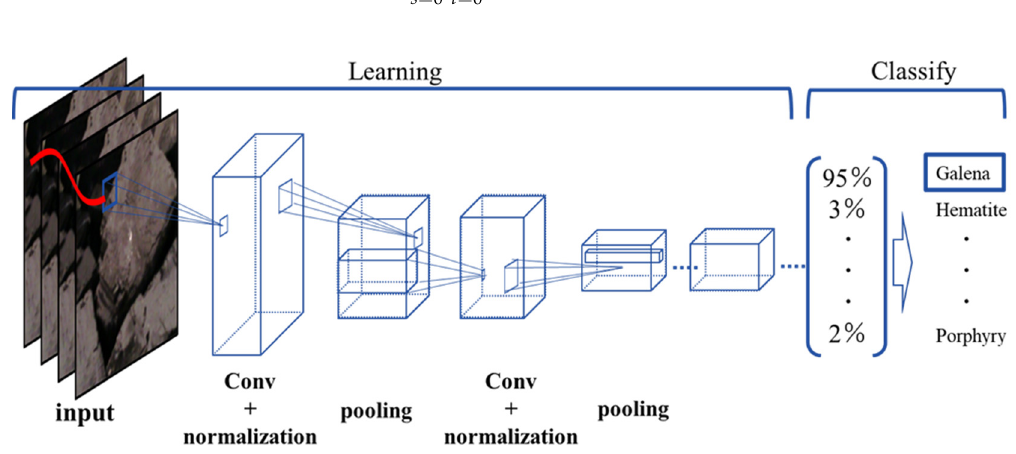
Figure 2. Structure of the convolutional neural network (CNN) for red, green, and blue (RGB) images.